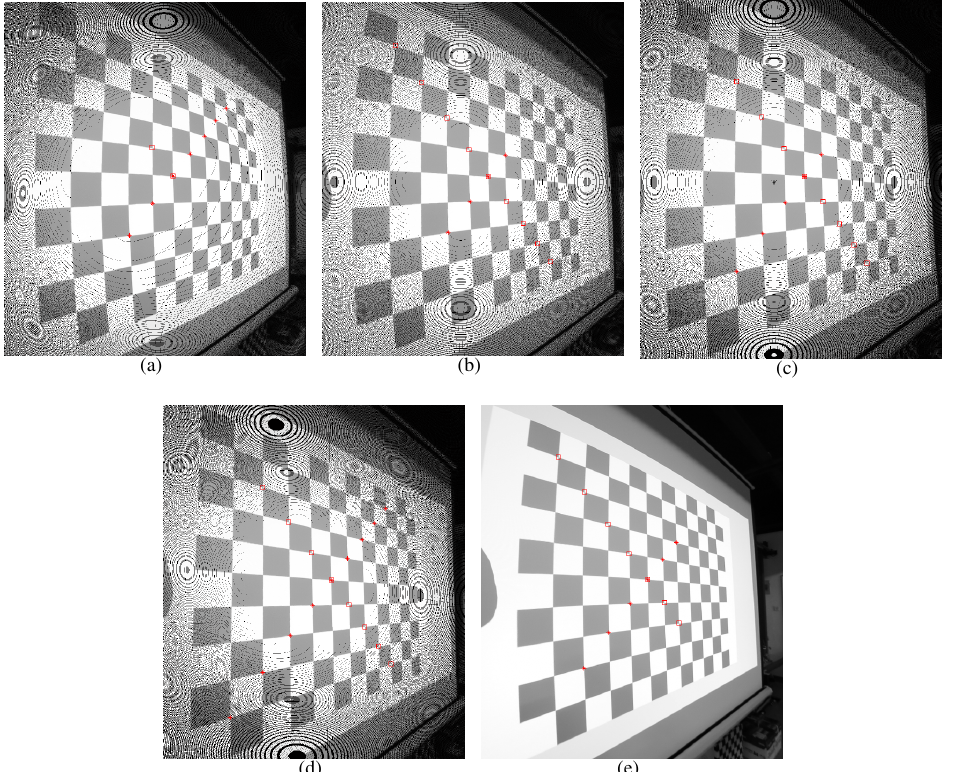
Figure 8: The corrected corner points at the diagonal direction using the RT model (a),FET model (b),PFET model (c),RF model (d),division model